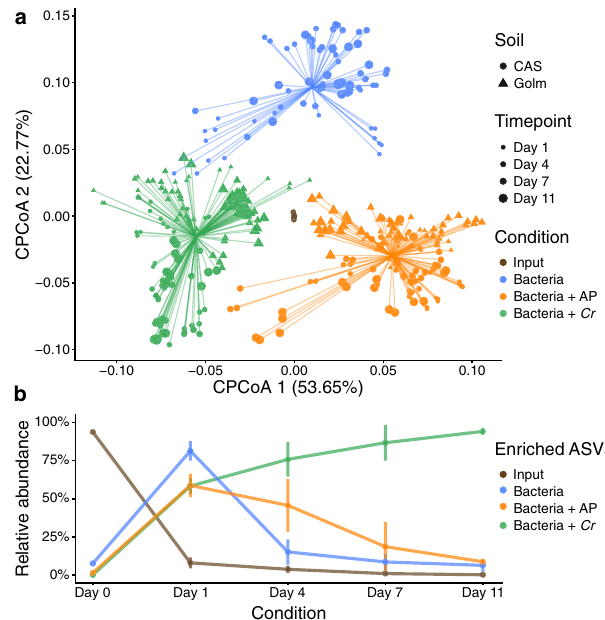
Fig. 3 Mesocosm experiments recapitulate the establishment of phycosphere communities by Cr across soil types and growth media. a PCoA analysis of Bray – Curtis dissimilarities of bacterial community pro fi les (ASV-level), constrained by condition (17.9% of the variance; P < 0.001), showing a signi fi cant separation between start inocula (soil washes, depicted in brown; n = 12), phycosphere communities (green; n = 158), and soil washes incubated in minimal media (blue; n = 112), or media supplemented with arti fi cial photoassimilates (APs, depicted in orange; n = 144). b Dynamic changes in the phycosphere community composition in terms of the aggregated relative abundances of ASVs enriched in each condition ( n = 158) with respect to the start inocula ( n = 12). Error bars represent the standard deviation of the